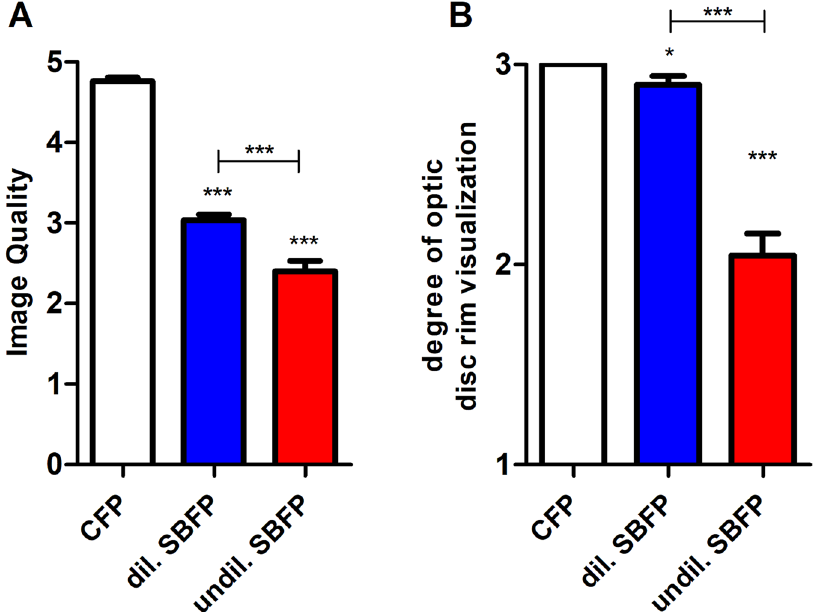
Figure 5. Evaluation of Image quality ( A ) and degree of optic disc rim visualization ( B ). Conventional fundus photography (CFP) and dilated (dil.) and undilated (undil.) smartphone-based fundus photography (SBFP) were compared. Error bars indicate standard error of the mean, paired t-test was used for analysis, asterisks indicate significant differences in regards to CFP if not otherwise indicated, * p < 0.05, *** p <